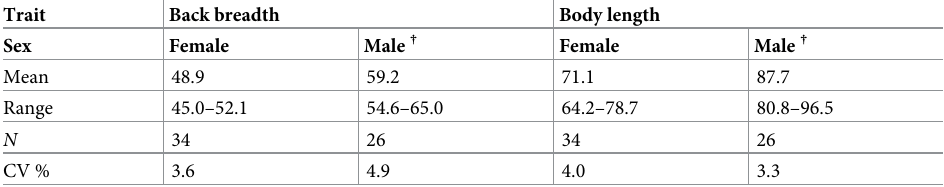
† Taken from Wright et al. [64]. CV % is calculated by dividing the standard deviation by the mean, multiplied by 100. For intra-individual CV % see S1 Table in S1